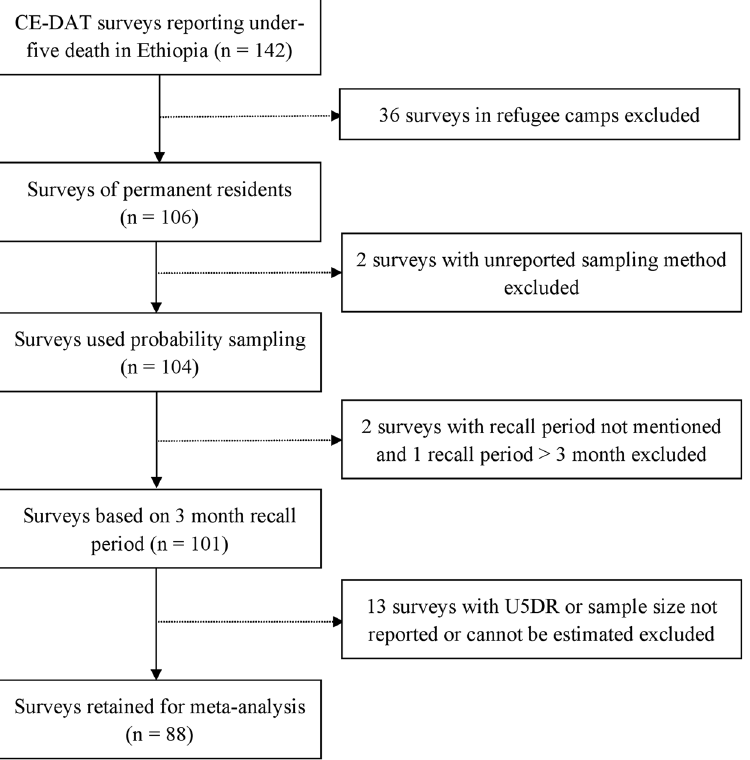
Figure 1. Flowchart of the small-scale mortality surveys included in the meta-analysis from Ethiopia, 2009– 2014. CE-DAT: Complex Emergency Database. USDR: Under-five Death